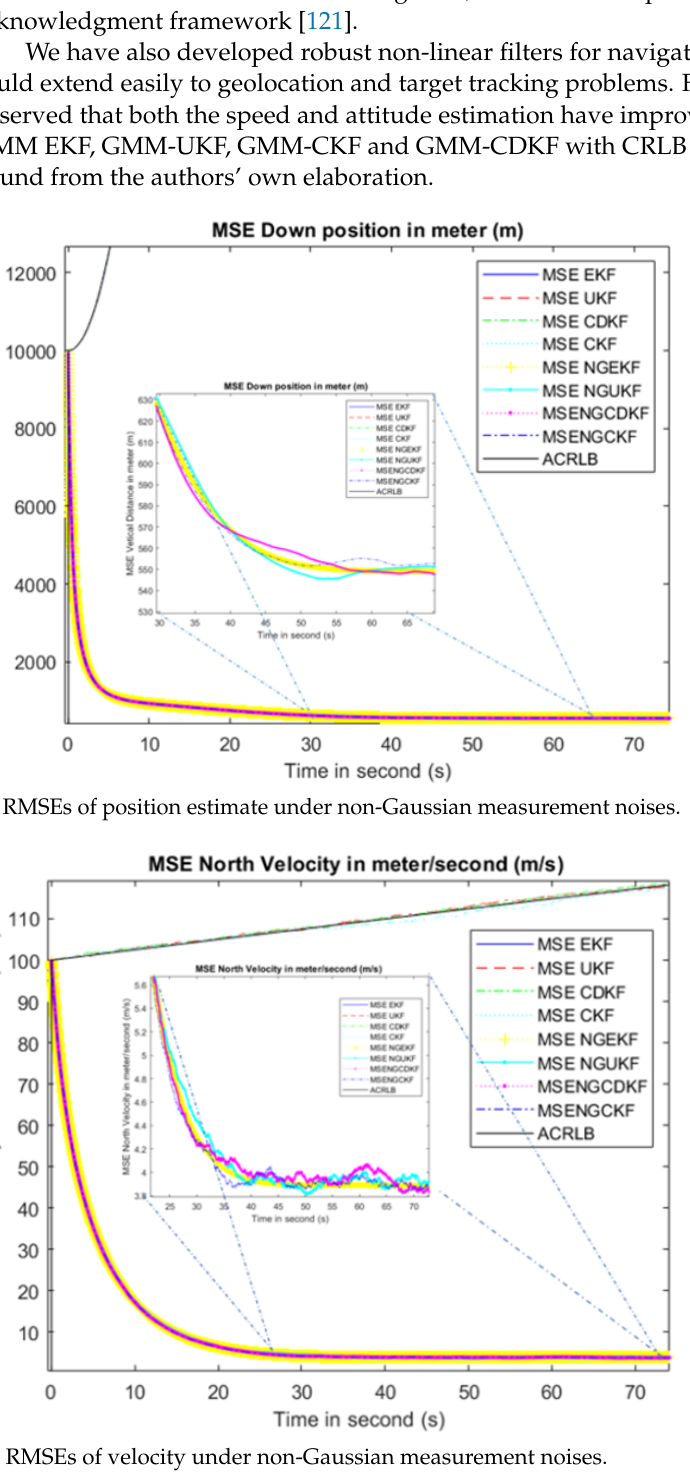
Figure 25. Performance comparison of GMM non-linear filters for robust navigation and information fusion algorithms. Authors’ own